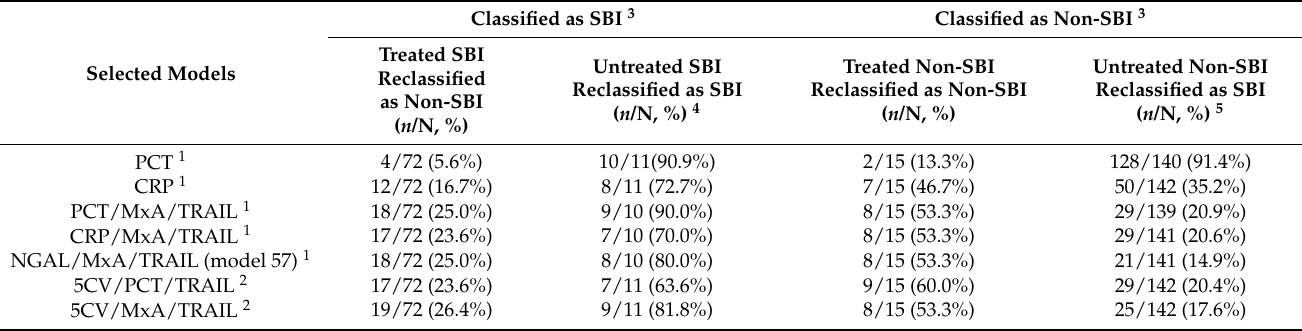
Table 4. Reclassification of serious bacterial infection (SBI) by the best models (TEST set; n =